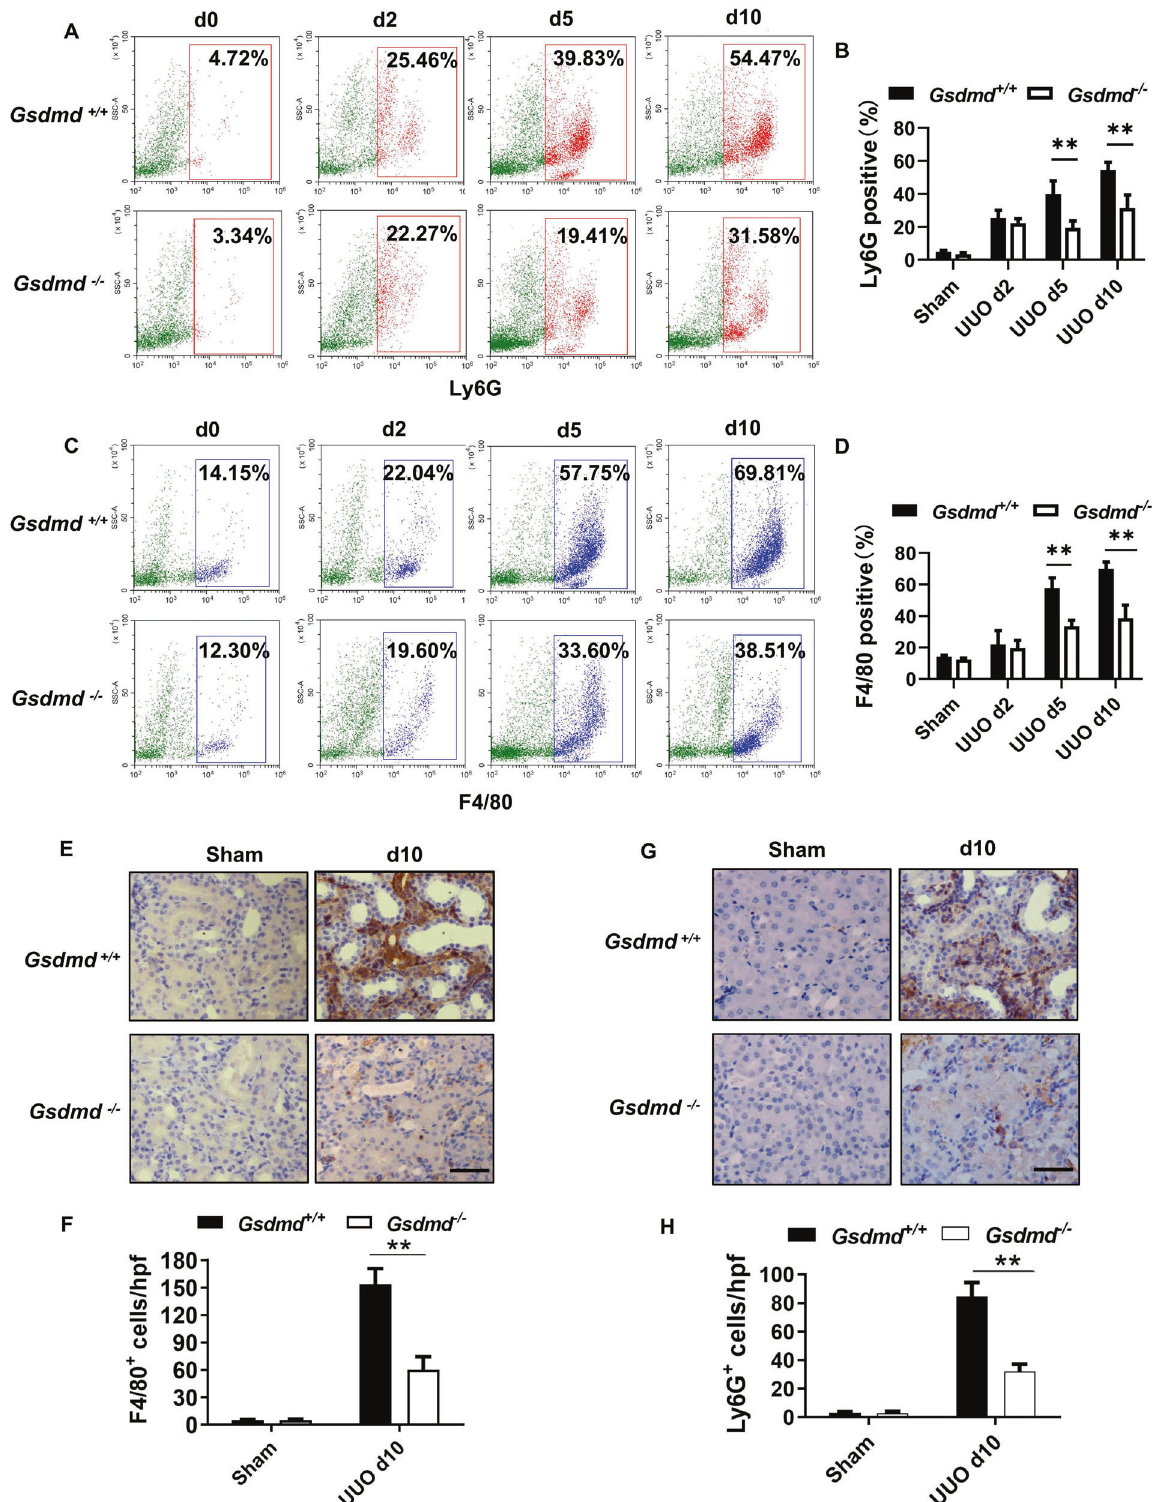
Fig. 2 Ablation of Gsdmd reduced the in fi ltration of neutrophils and macrophages in the kidneys after UUO. A , C Flow cytometry was used to evaluate the cellular dynamics of neutrophils (Ly6G + ) and macrophages (F4/80 + ) in fi ltration in the kidneys of Gsdmd + / + mice and Gsdmd − / − mice on day 0, 2, 5, and 10 after UUO. Representative images of fl ow cytometry analysis were shown in A and C. B , D Quanti fi cation of the percentage of neutrophils (Ly6G + ) and macrophages (F4/80 + ) in fi ltration. n = 3. E , G Representative images of immunohistochemistry staining with F4/80 + E and Ly6G + G . Scale bar: 100 μ m. F , H Quanti fi cation of the number of F4/80 + and Ly6G + cells per hpf. n = 5. ** P < 0.01.